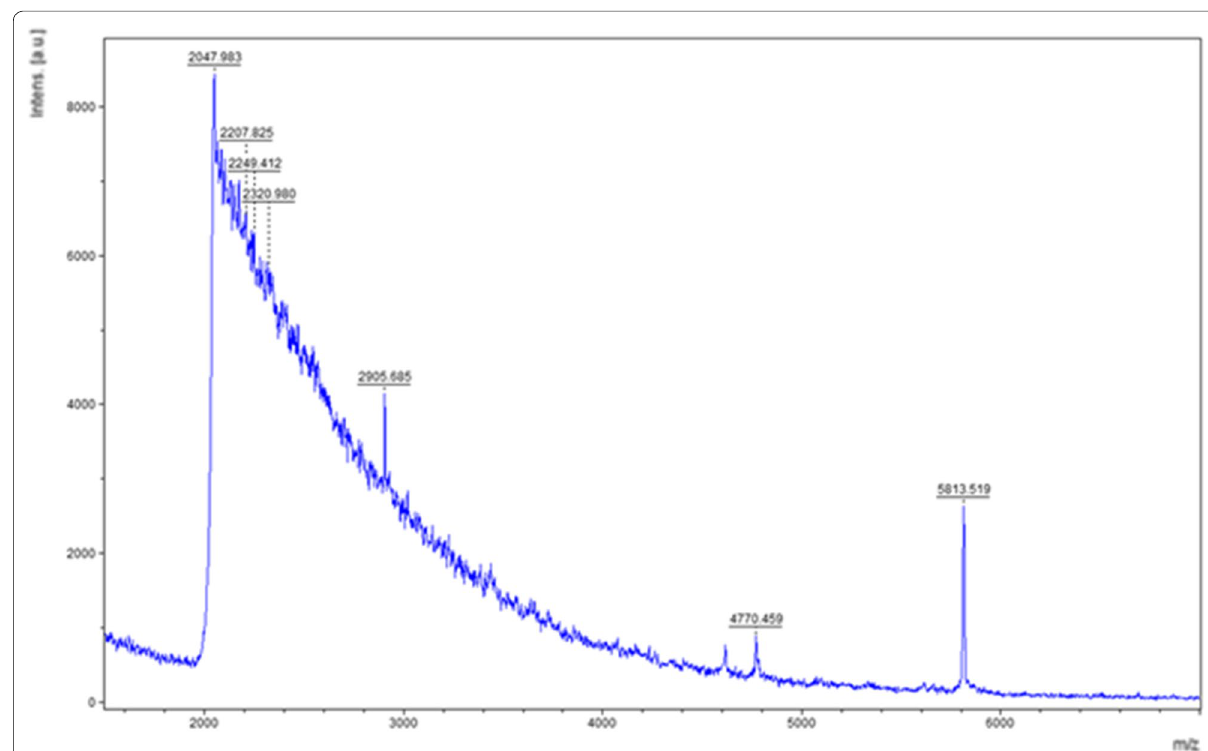
Fig. 2 A MALDI-TOF spectrum illustrating the supernatant sample of crude biosynthesised human insulin, which was induced at 1 mM IPTG